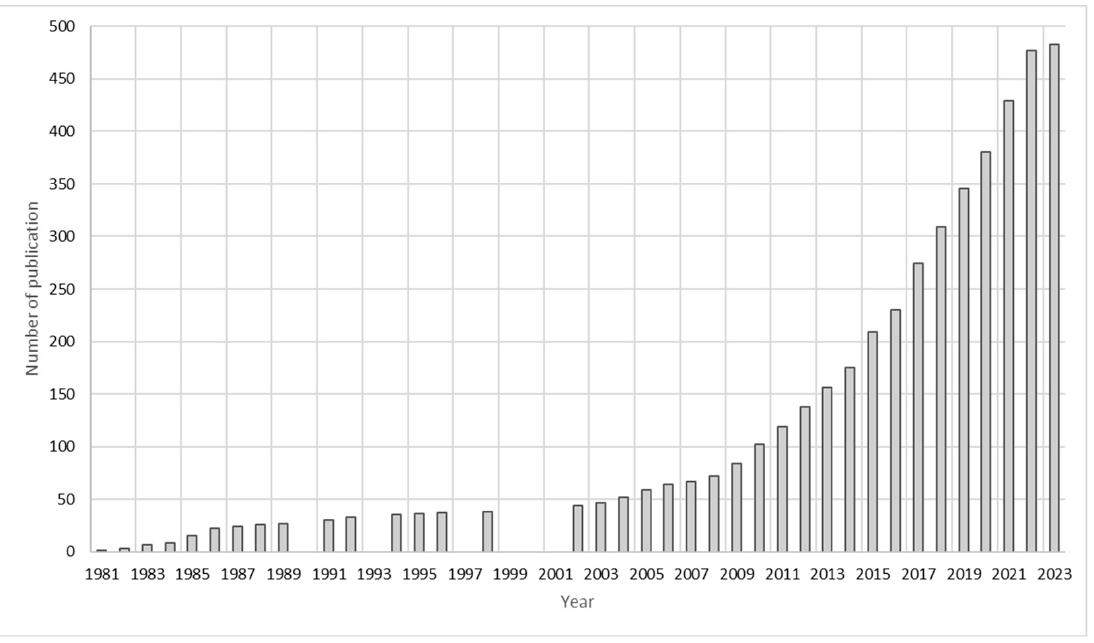
Figure 2. Cumulative number of publications during the years on the topic “ thermal transmittance assessment of building* ” (source: authors’ elaboration based on Scopus data). The United States (n. 76) and the United Kingdom (n. 63) are the most active, followed by Canada (n. 31), China (n. 26), Italy (n. 26), Saudi Arabia (n. 24), Spain (n. 24), India (n. 23), and South Korea (n. 23). Studies on this topic are published more or less in each country, despite Europe and Asia being the most active continents (Figure